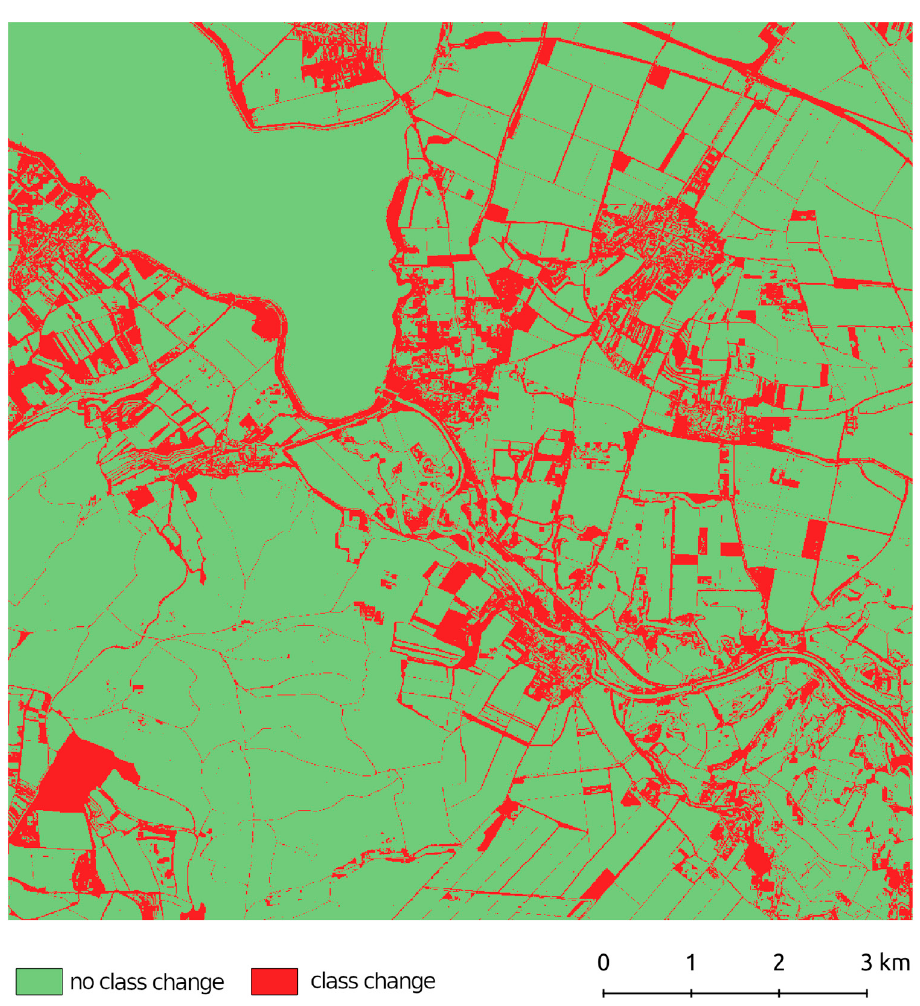
Figure 7. Monitoring class mismatch between the original cadaster data and the LightGBM prediction to visually assess the results of the classification. Sources: Sentinel-2 imagery from 30.3 to 16.10.2019 [80], Czech cadastral map [85].